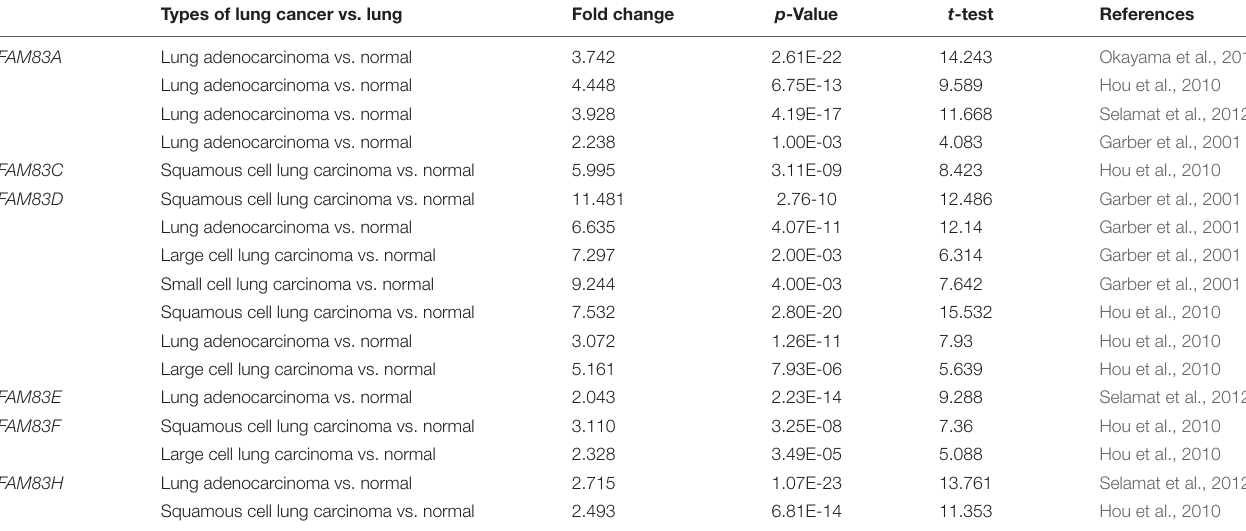
TABLE 2 | Remarkable changes of FAM83 family expression in transcription level between lung cancer and normal lung tissues (ONCOMINE). Types of lung cancer vs. lung Fold